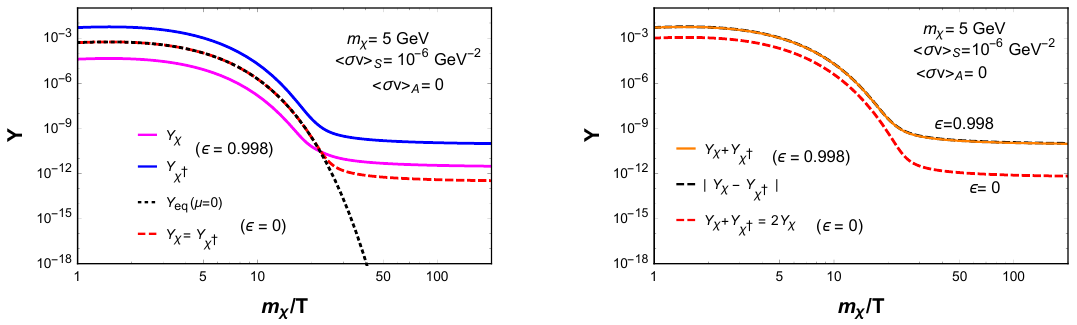
Figure 2 . Dark matter ( Y (cid:31) ) and anti-dark matter yields ( Y the scenarios with no CP-violation ( (cid:15) = 0) and nearly maximal CP-violation ( (cid:15) = 0 : 998). The individual yields are shown in the left (cid:12)gure, while their sum and di(cid:11)erence are shown in the right. See text for